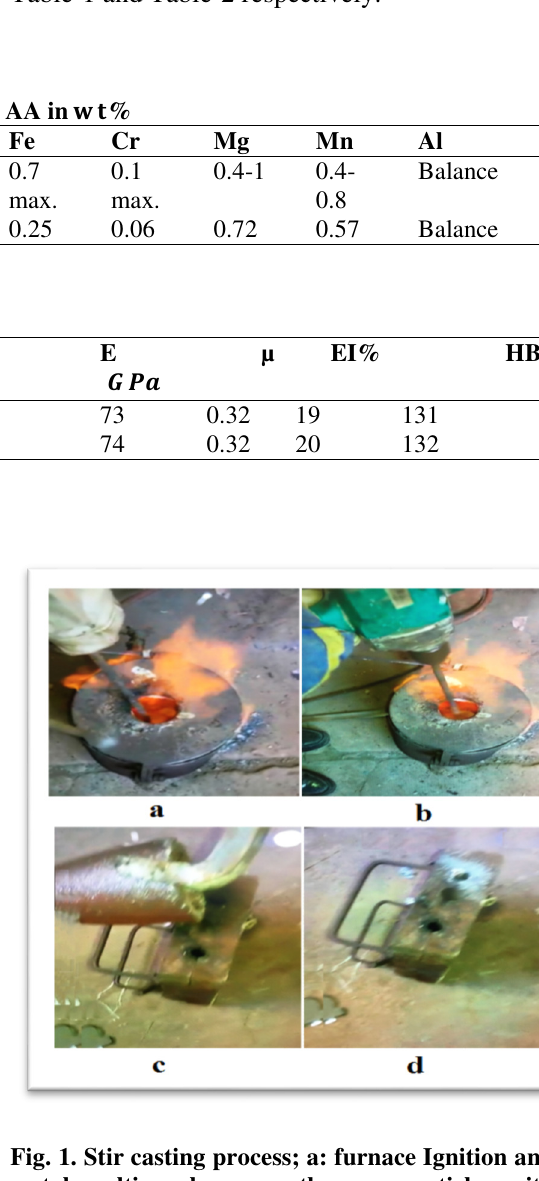
Fig. 1. Stir casting process; a: furnace Ignition and metal melting; b: move the nanoparticles with molten metal; c: the melt poured into the mold; d: composites product into